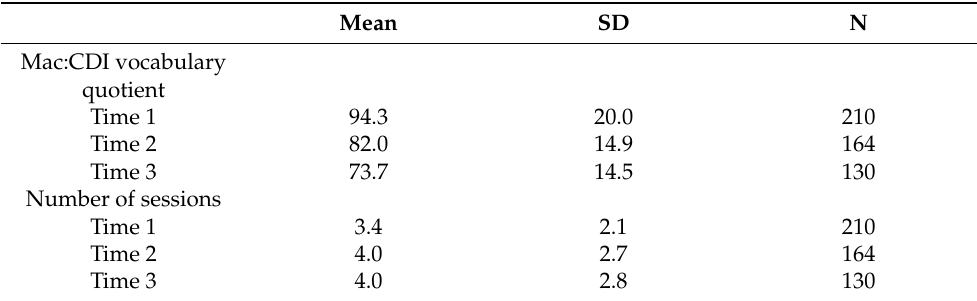
Table 4. Means and Standard Deviations for Vocabulary Quotients and the Average Number of Intervention Sessions Per Month.